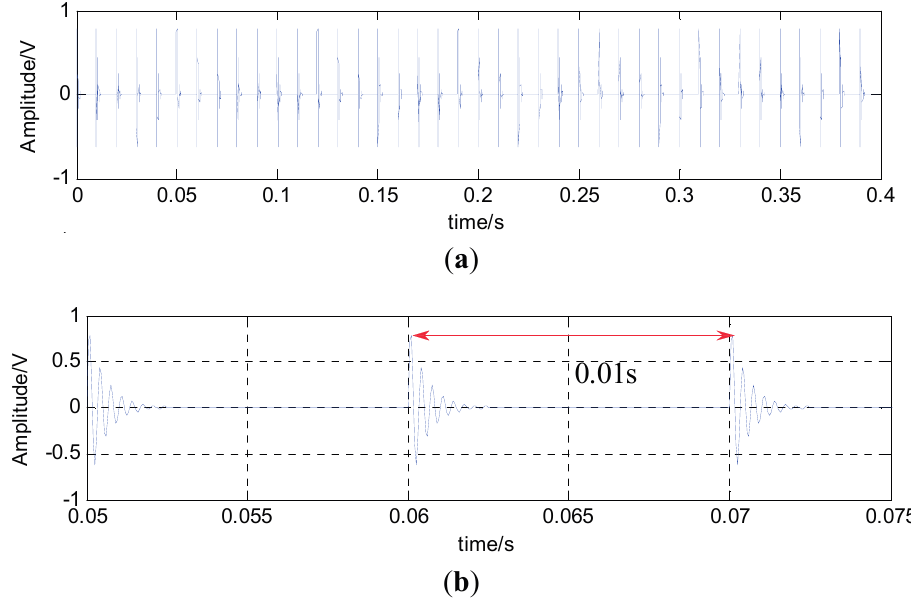
Figure 2. ( a ) Simulated fault signal of the rolling bearing; ( b ) local amplification of the simulated fault signal of the rolling